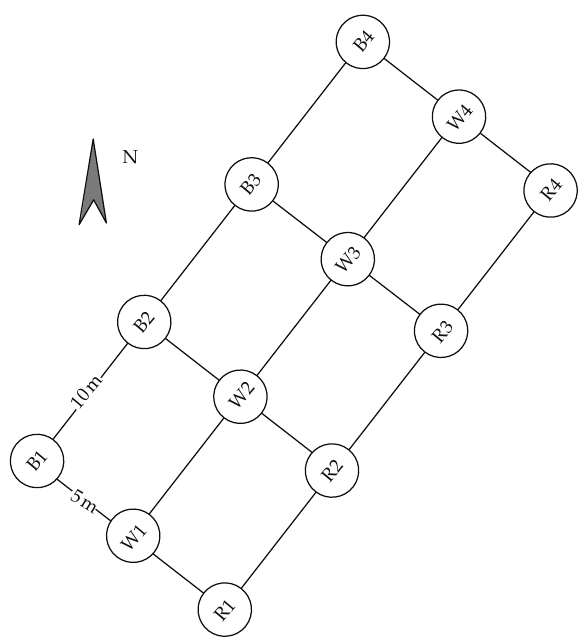
Figure 1: Actual shape of test